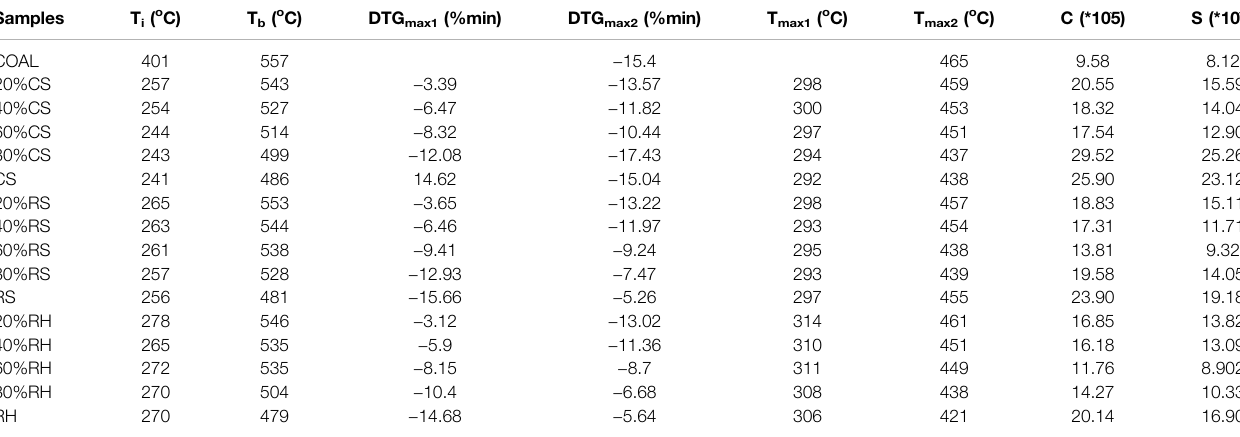
TABLE 3 | Combustion characteristic parameters of the blends.